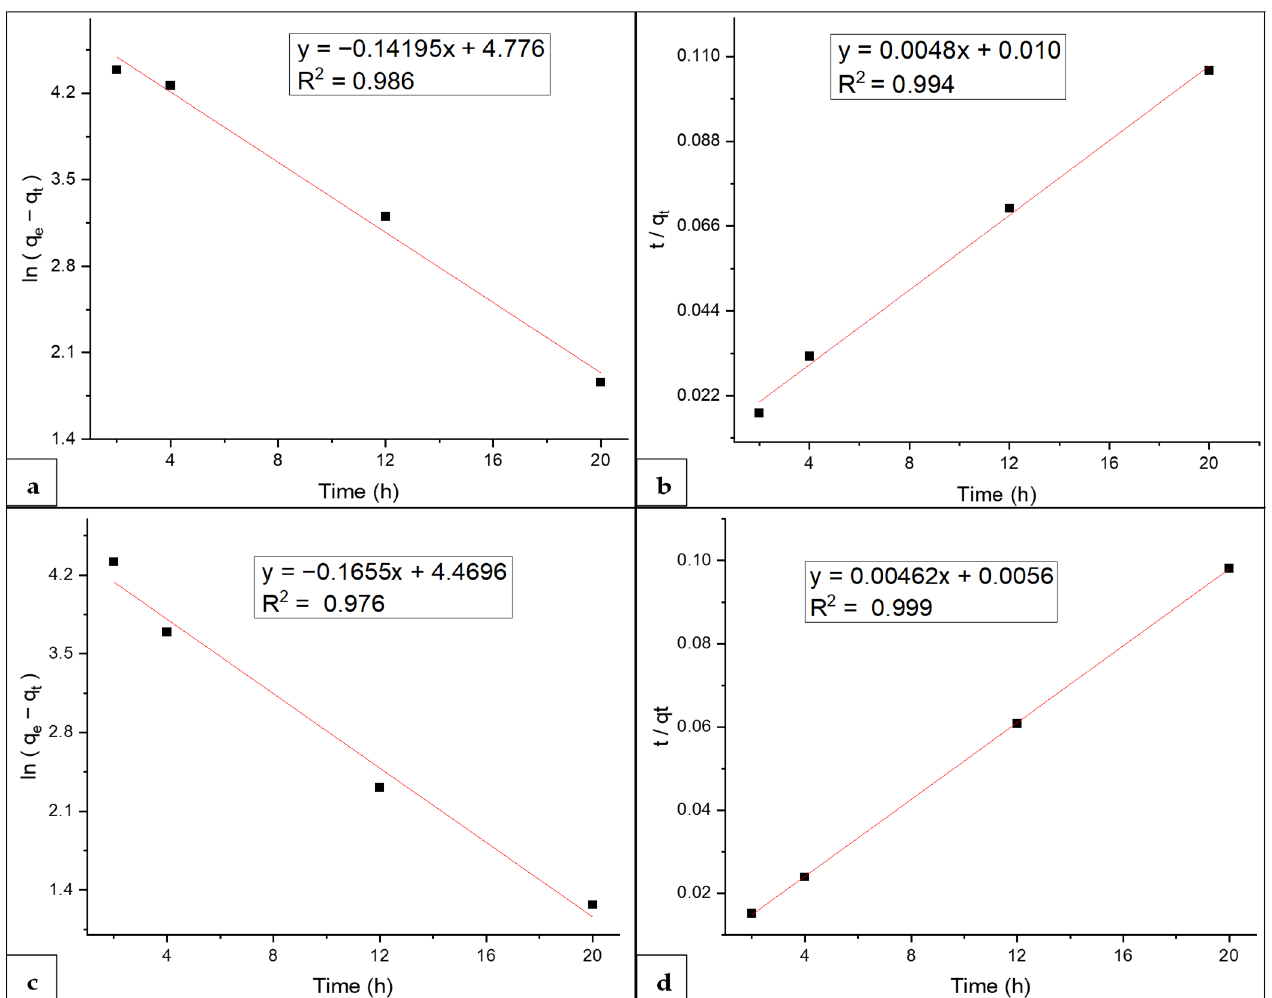
Figure 12. MB adsorption kinetics: ( a ) pseudo first-order and ( b ) pseudo second-order using SAP, and ( c ) pseudo first-order and ( d ) pseudo second-order using SAP-AC as adsorbent. From the given straight-line equations, the values for q e , K 1 , and K 2 were calculated